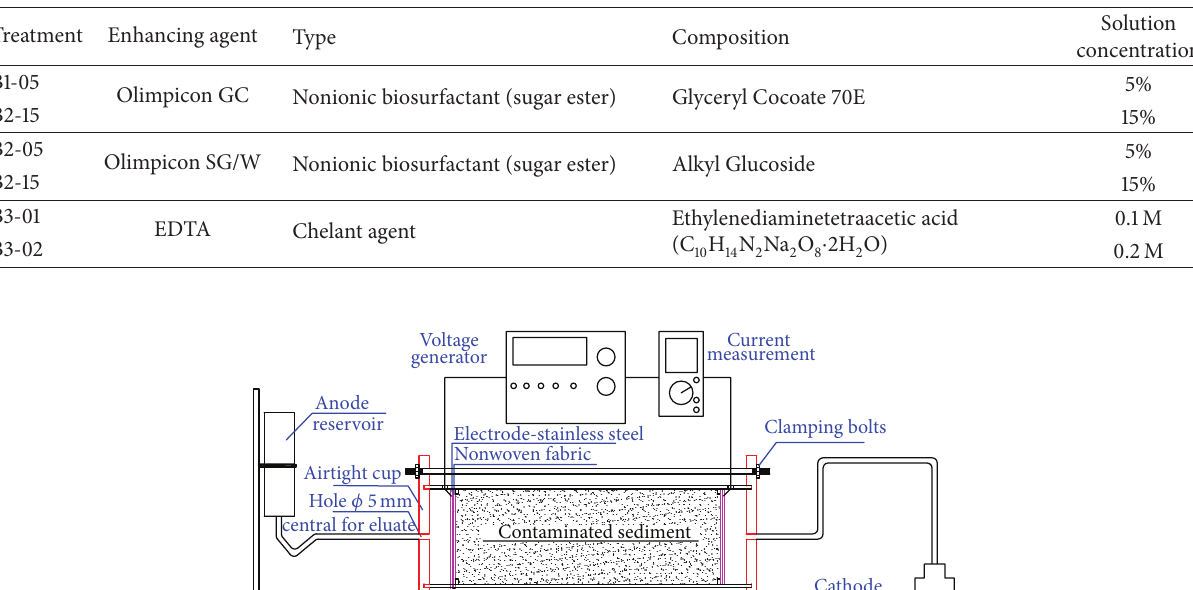
Table 2: Experimental matrix for batch tests.